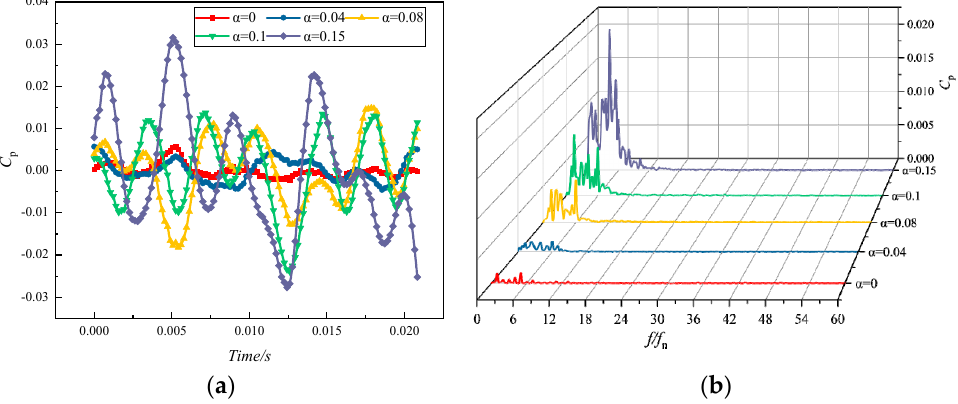
Figure 13. Pressure pulsation characteristics of monitoring point Y1 at different inlet gas fractions: ( a ) time-domain distribution; ( b ) frequency-domain distribution.